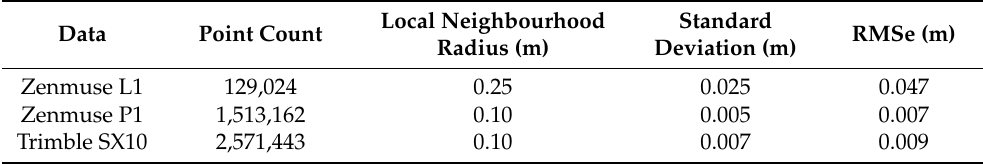
Table 15. Roughness analysis of metric data related to the entrance